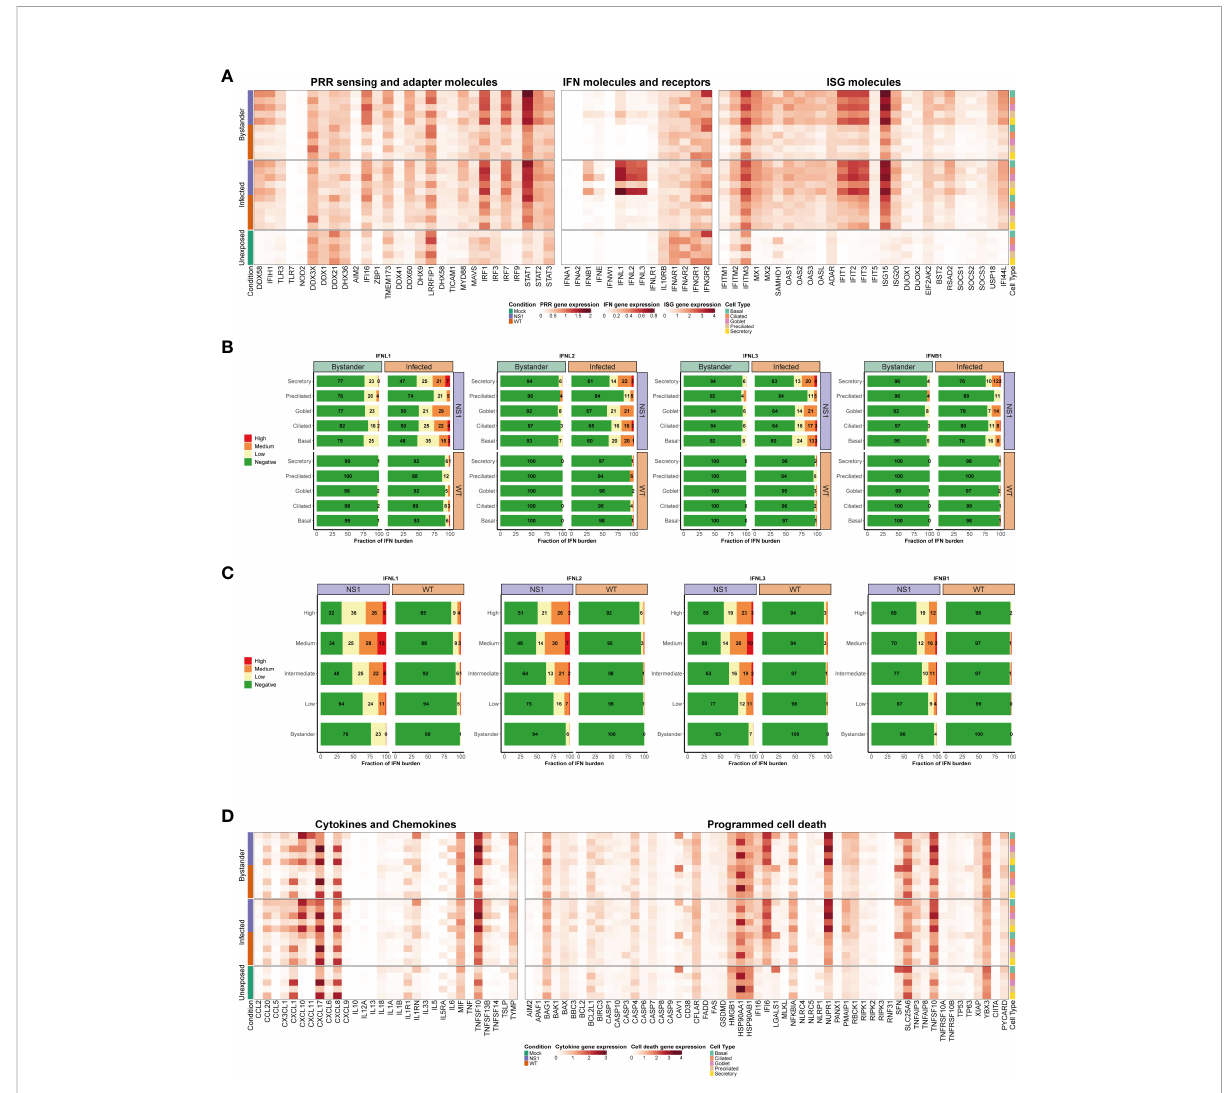
FIGURE 6 Cell type-speci fi c host antiviral response to pandemic IAV infection. (A) Heatmap illustrating the average expression levels for well-known antiviral genes, including PRR sensing and adapter genes (left panel), IFN genes and their receptors (middle panel), and ISG genes (right panel). Expression levels for individual genes are shown in columns and strati fi ed by condition, infection status, and cell type (rows; representative colors shown in legends). (B) Stacked bar plots showing the fraction of cells expressing low (yellow), medium (orange), or high (red) levels of either type I or III IFNs. Green represents the fraction of cells that were not expressing the IFN in question. For each bar graph, the cells are divided by condition, infection, status, and cell type. (C) Bar graphs illustrating the fraction of cells expressing different levels of type I and III IFNs (low, medium, or high expression levels are colored yellow, orange, or red, respectively; negative cells colored green). In these plots, WT and NS1 R38A cells are divided by viral burden (i.e., bystander cell with no viral burden or infected cell with a low, intermediate, medium, or high viral burden; categories are labeled on the left side of each plot). (D) Heatmap showing the average expression levels of various cytokines and chemokines (left panel) as well as many genes involved in programmed cell death (right panel). The heatmap is strati fi ed by condition, infection status, and cell type (rows) for each gene